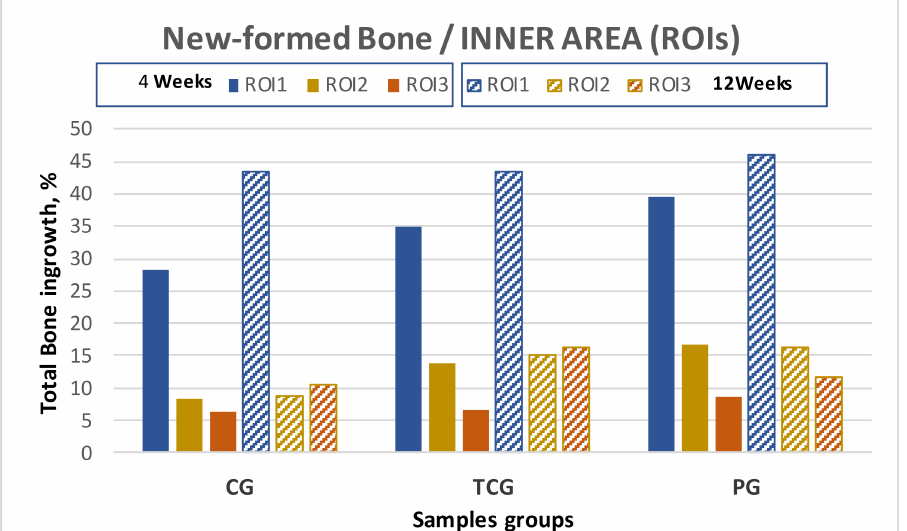
Figure 2. New bone formation in titanium porous foam at 4 and 12 weeks after implantation. There were no statistically significant differences ( p > 0.05) depending on the type of samples for all analyzed